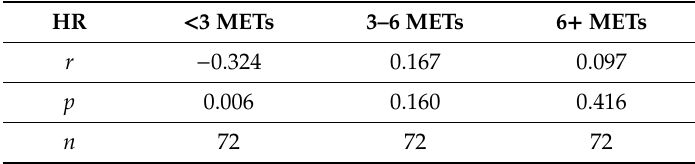
Table 2. Pearson correlations between HR and METs of both